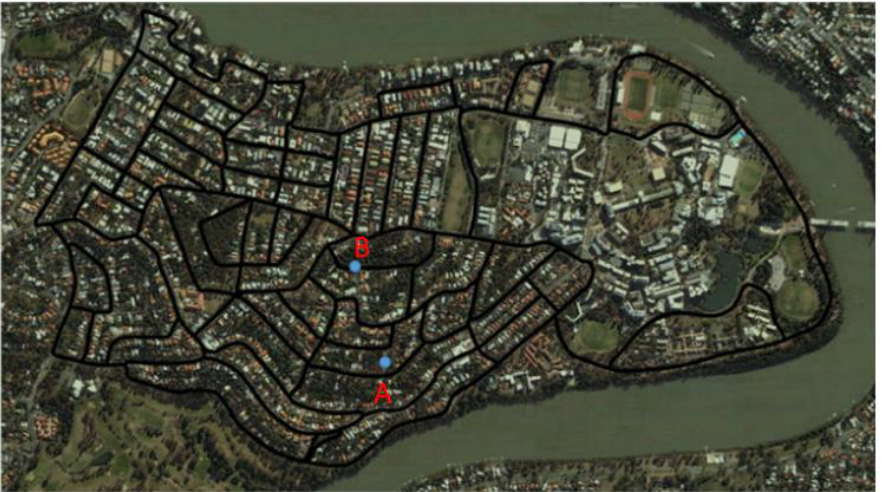
Figure 9. Saint Lucia open dataset roadmap.